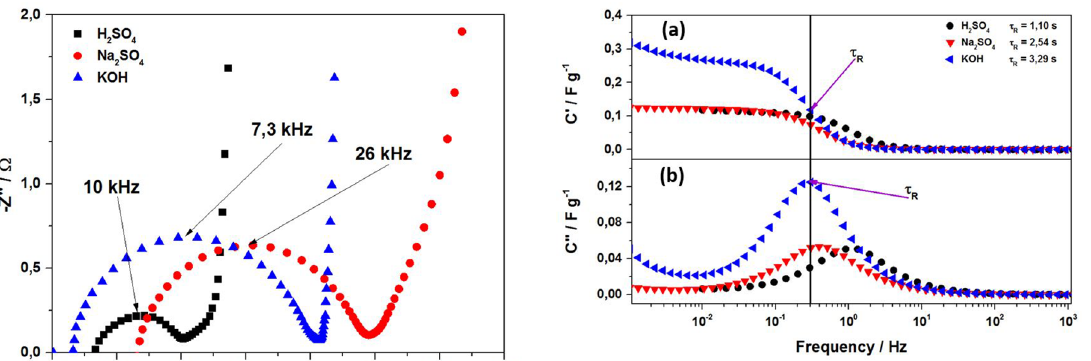
Figure 7. Progress of the a) real part and b) imaginary capacitance vs. frequency of